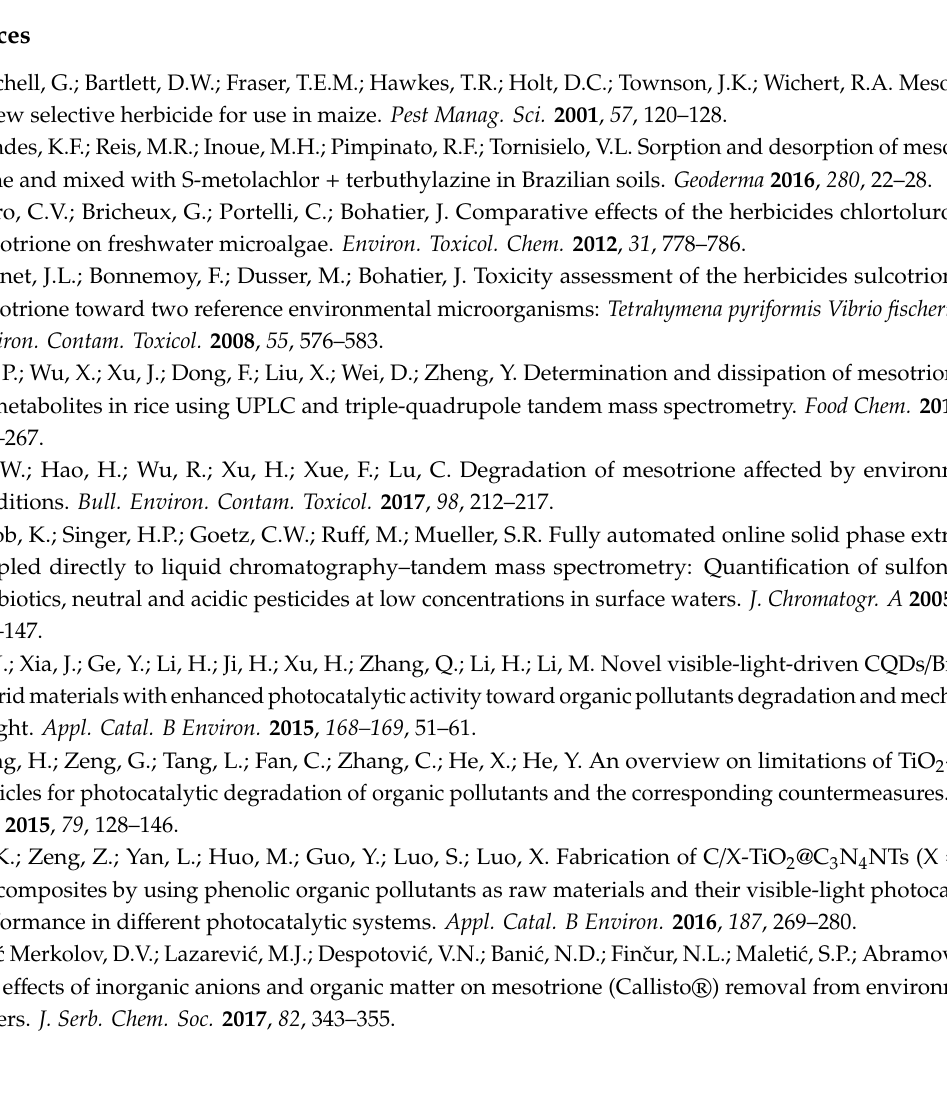
photodegradation and analytical procedure details, Figure S1: The measured α of the samples: 2.43 × 10 –3 % Table S1: The band gap energies and their corresponding wavelengths, Figure S2: The influence of di ff erent n × 10 8 (mol) of Au nanoparticles on mesotrione (0.05 mM) photolytic degradation using simulated sunlight, Figure S3: The influence of di ff erent n / n × 10 3 (%) of: (a) Au; (b) Au–S–CH 2 –CH 2 –OH, as well as (c) Au–S–CH 2 –CH 2 –OH–FNP and TiO 2 (0.5 g / L) on the e ffi ciency of mesotrione (0.05 mM) photocatalytic degradation under simulated sunlight, Figure S4: The influence of di ff erent n / n × 10 3 (%) of: (a) Au; (b) Au–S–CH 2 –CH 2 –OH, as well as (c) under simulated sunlight, Figure S5: The MS spectra of mesotrione and detected products (ESI, negative